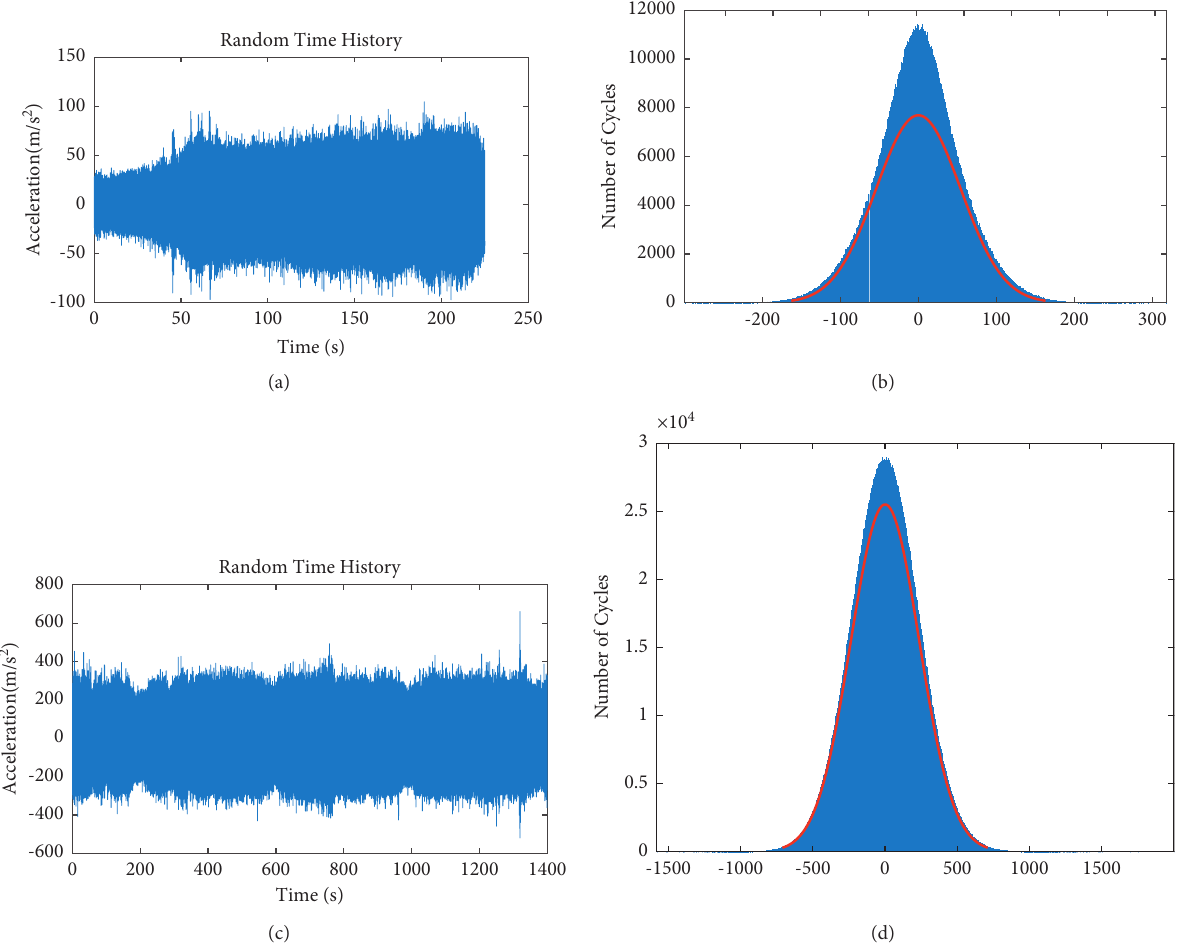
Figure 4: Input Gaussian excitation and non-Gaussian excitation and their amplitude distribution. (a) Climb task segment time-domain acceleration. (b) Time-domain signal distribution inspection of climb task segment. (c) Flat flight 2 task segment time-domain acceleration. (d) Time-domain signal distribution inspection of flight